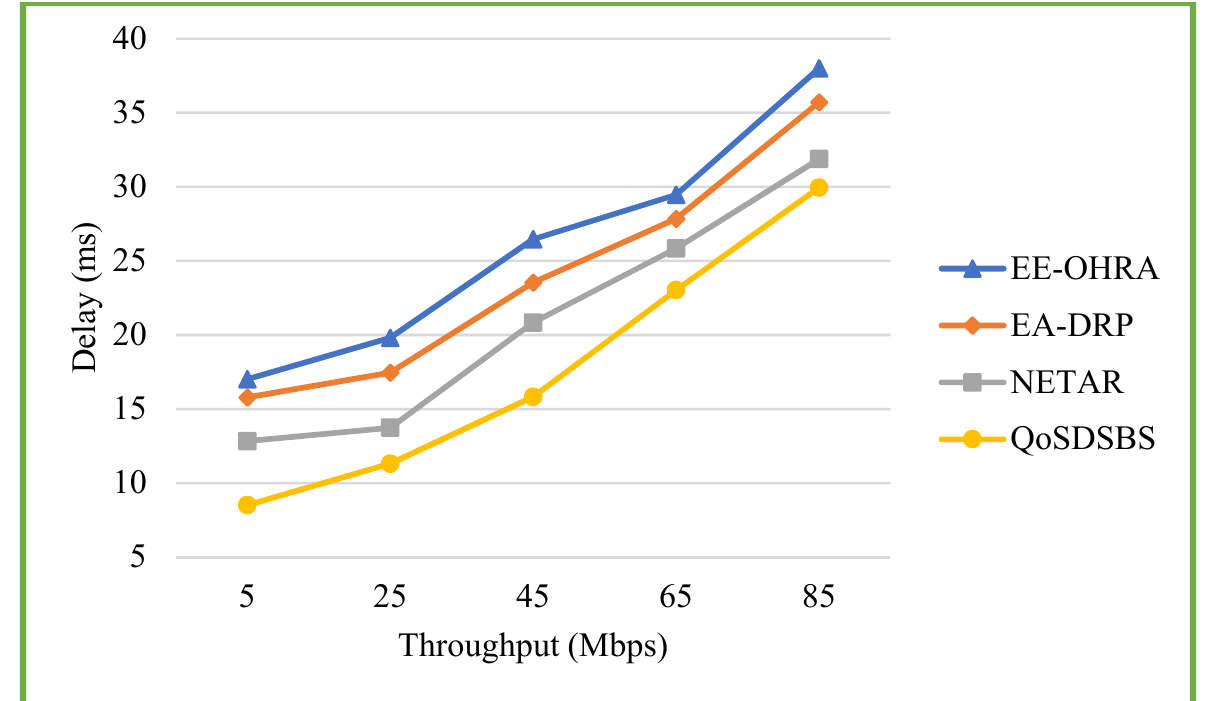
Figure 9. Throughput vs. delay. Table 6. Results of throughput vs. delay.